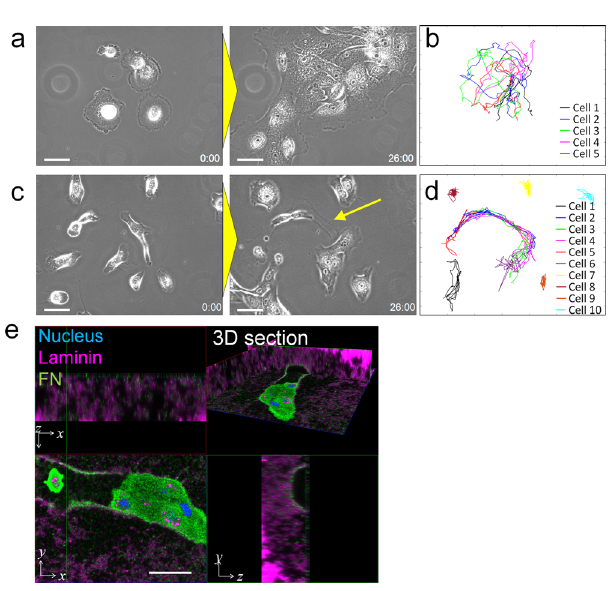
Fig. 3 Effects of the modi fi cation of ECM resistance force on cellular behaviour. a Time-lapse images of NHBE cell behaviour without matrigel cover. b Cell tracking results of cells in Fig. 4a. The initial fi ve cells were tracked over a period of 16 hours. c Time-lapse images of NHBE cell behaviour with matrigel cover. The arrow shows the track made by the cell along its path of movement. d Cell tracking results of cells in Fig. 4c. The initial 10 cells were tracked over a period of 16 hours. e 3D immunostaining of laminin and FN was used to show the distribution of matrigel and FN footprint during cell migration, respectively. A tunnel was visible in the path of cell movement, and traces of FN remained in the tunnel. Scale bar: 100 μ m ( a , c , e